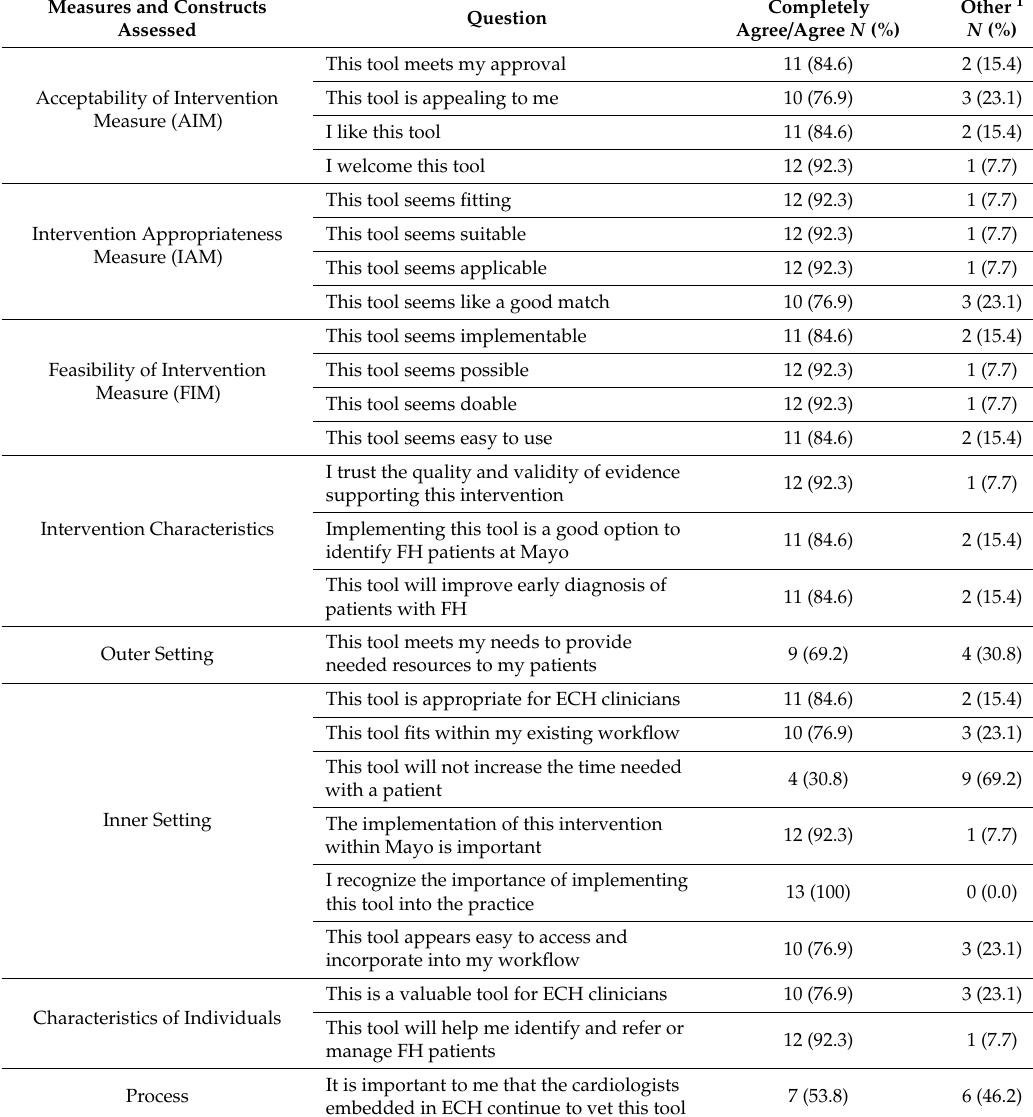
Table 4. Implementation outcome measures by Weiner et al. and Consolidated Framework for Implementation Research (CFIR) constructs were assessed through a post-interview survey conducted with PCPs and